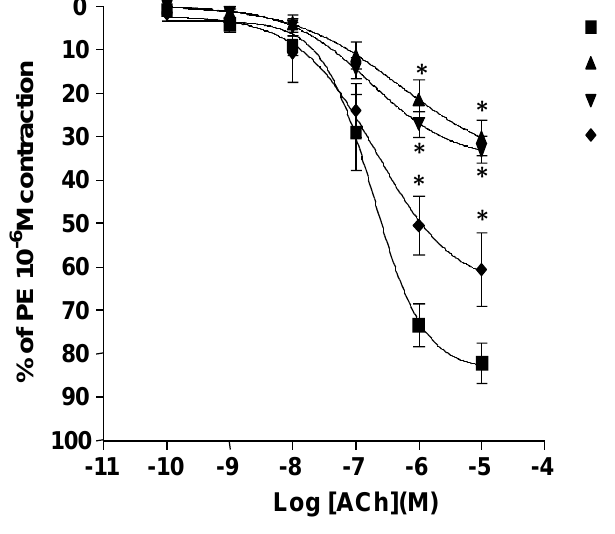
Figure 4. Effect of SOD, a superoxide scavenger and 0.5 μ g/mL P.grandis (stem bark) methanolic extract in the presence of pyrogallol (non-enzymatic superoxide inducer) on Ach-induced relaxation in rat aortic rings. Results are mean ± S.E.M (n = 5–6). Significant difference from control is indicated by * (p <